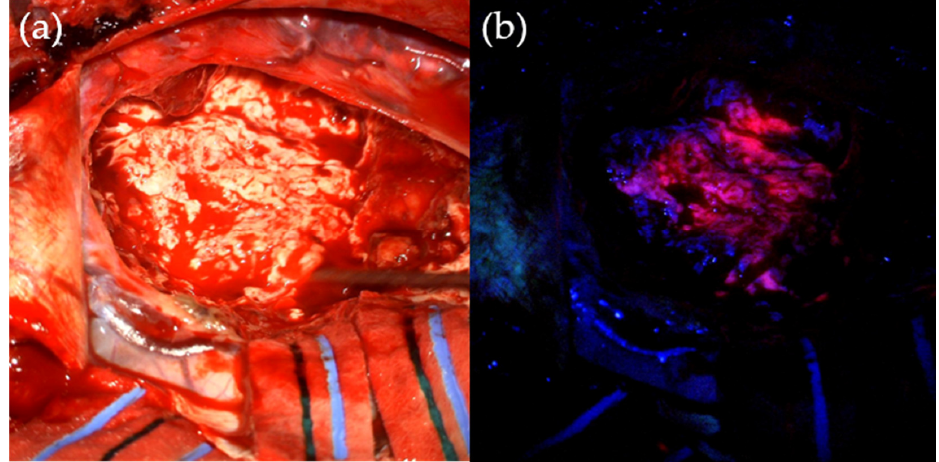
Figure 2. Intra-operative use of 5-ALA. ( a ) Tumour under standard operating white-light. ( b ) Pink fluorescence of tumour tissue, shown after 5-aminolevulinic acid administration and under operating microscope blue light filter.